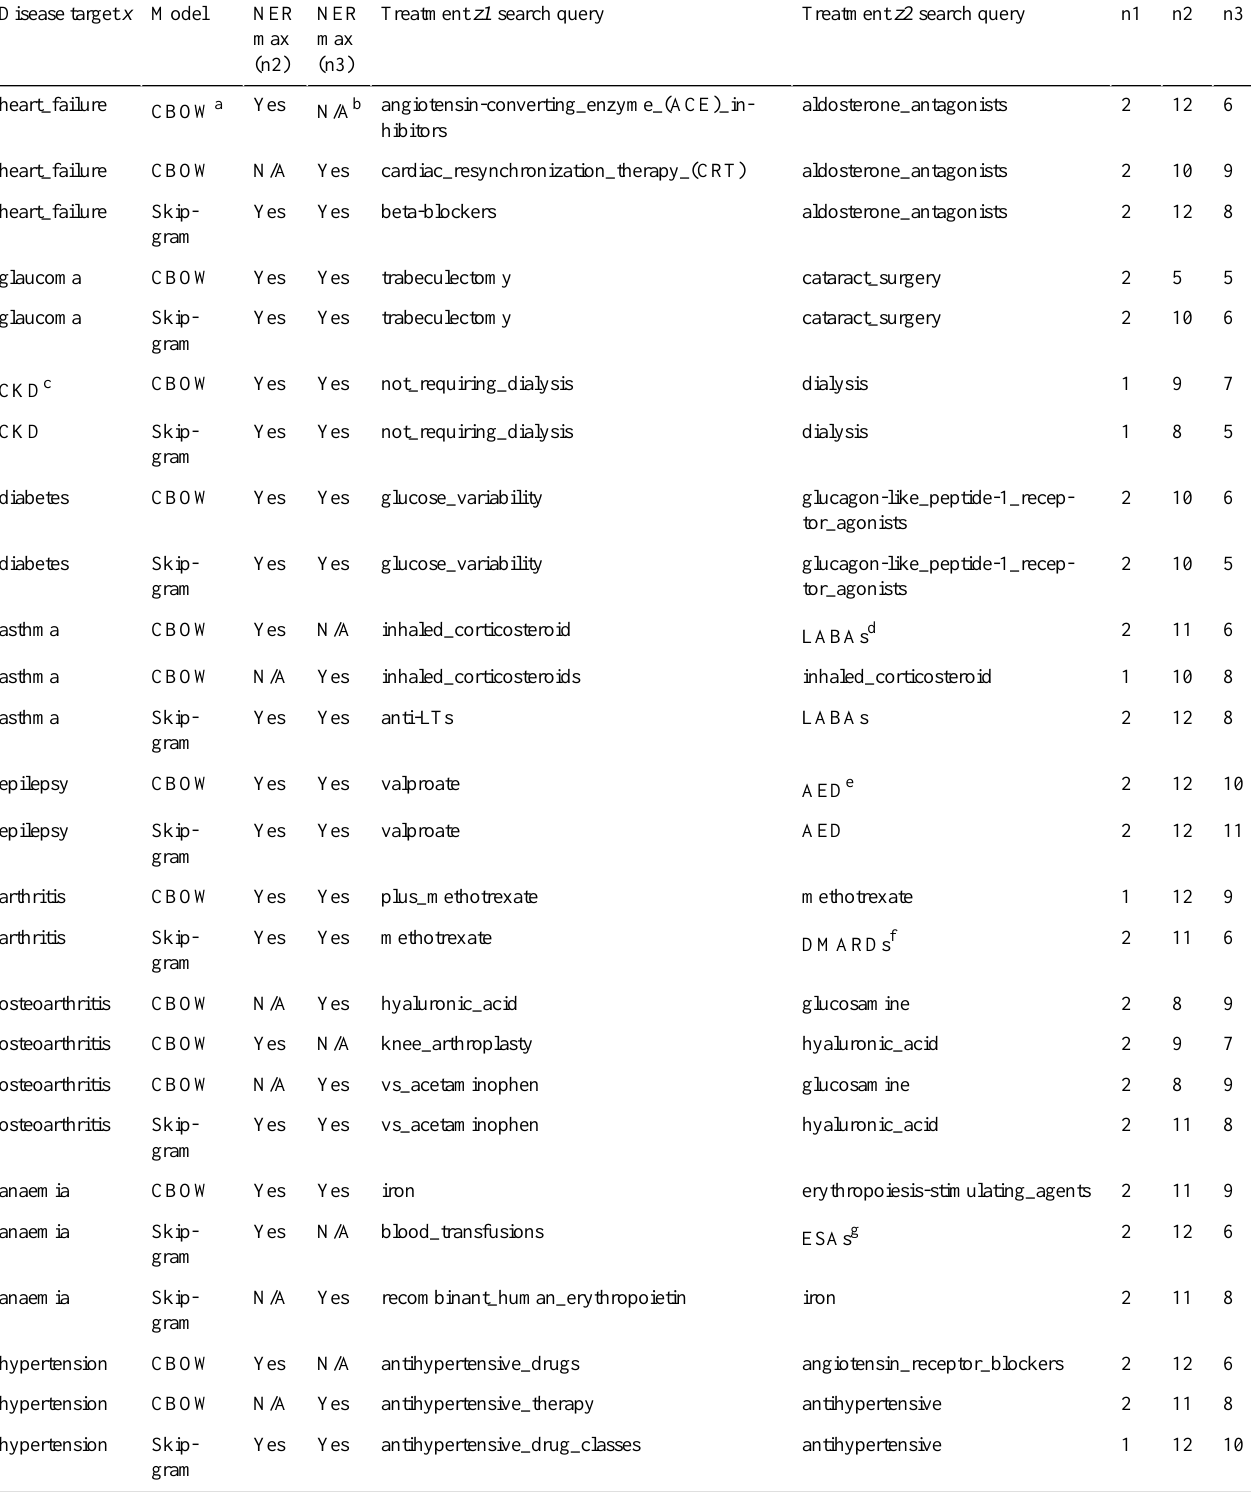
Table 2. NER winners per target disease x (search query -x +z1 +z2) for the 3CosAdd formula, that is, the highest value for n2 or n3 per model and per disease target